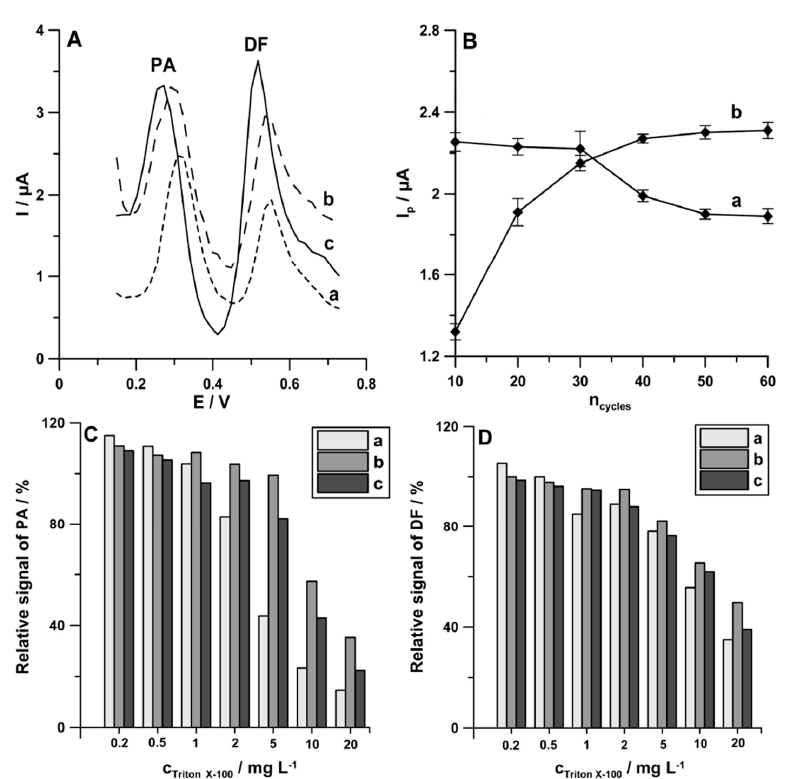
Figure 7. ( A ) DPAdSV curves registered in the solution containing PA (1.0 × 10 − 6 mol L − 1 ) and DF (1.0 × 10 − 8 mol L − 1 ) using the following: (a) accumulation potential of − 0.25 V for 60 s; (b) a 1 s accumulation period at a potential of potential of − 0.25 V and the anodic pulse with the differential-pulse scan from − 0.25 to 0.1 V ( n cycle s = 60); (c) a 1 s accumulation period at a potential of 0.1 V and a 1 s accumulation period at a potential of − 0.25 V ( n cycle s = 60). ( B ) Effect of n cycle s on 1.0 × 10 − 6 mol L − 1 PA (a) and 1.0 × 10 − 8 mol L − 1 DF (b) current responses. Relative signals of 1.0 × 10 − 6 mol L − 1 PA ( C ) and 1.0 × 10 − 8 mol L − 1 DF ( D ) in the presence of increasing concentration of Triton X-100 with the parameters described in Figure 6A (curve c).